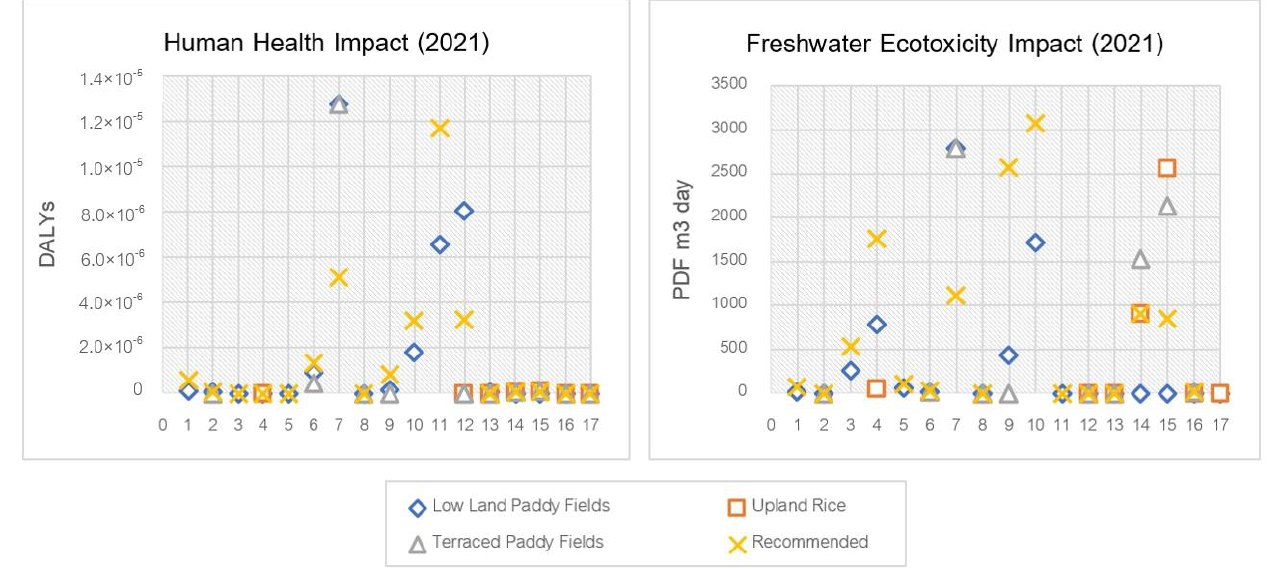
Figure 3 . Human health and ecotoxicity impact scores on pesticide use in rice cultivation in 2021 . 1 . Chlorpyrifos, 2 . Glyphosate, 3 . Acephate, 4 . Alachlor, 5 . Butachlor, 6 . 2,4 - D dimethyl ammonium, 7 . Fipronil, 8 . Metaldehyde, 9 . Mancozeb, 10 . Atrazine, 11 . Atrazine ( cancer ) , 12 . Acephate, 13 . Acephate ( cancer ) , 14 . Carbendazim, 15 . Cypermethrin, 16 . Captan, and 17 . Captan ( cancer ).